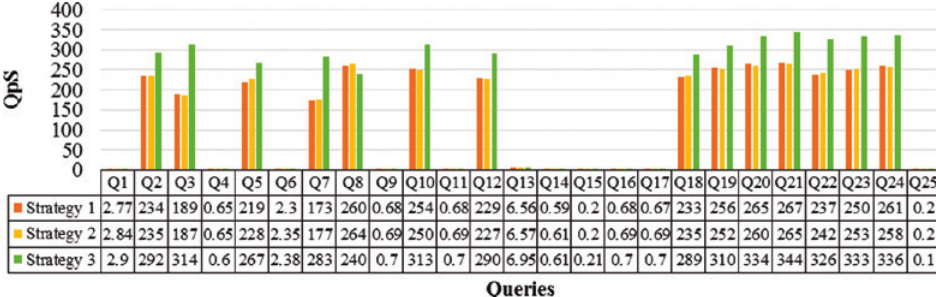
Figure 10: QpS Analysis of Three Strategies on Three Ontologies and A-BOX of Size